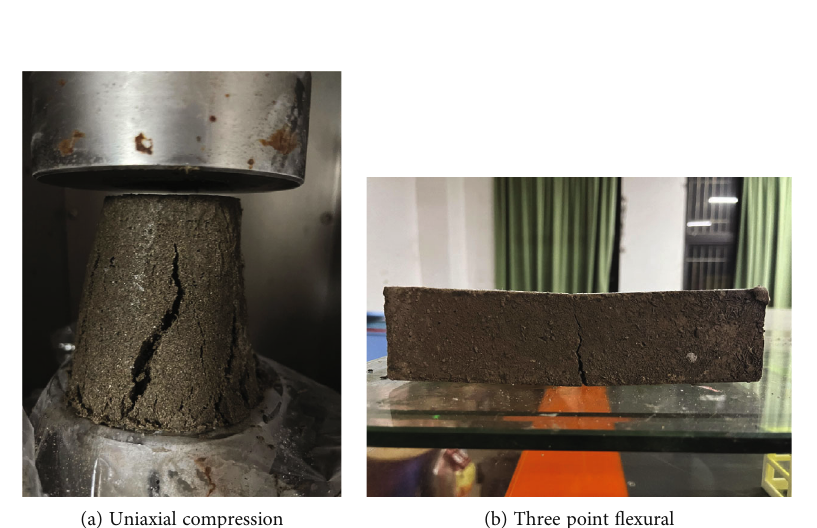
Figure 5: Failure mode of